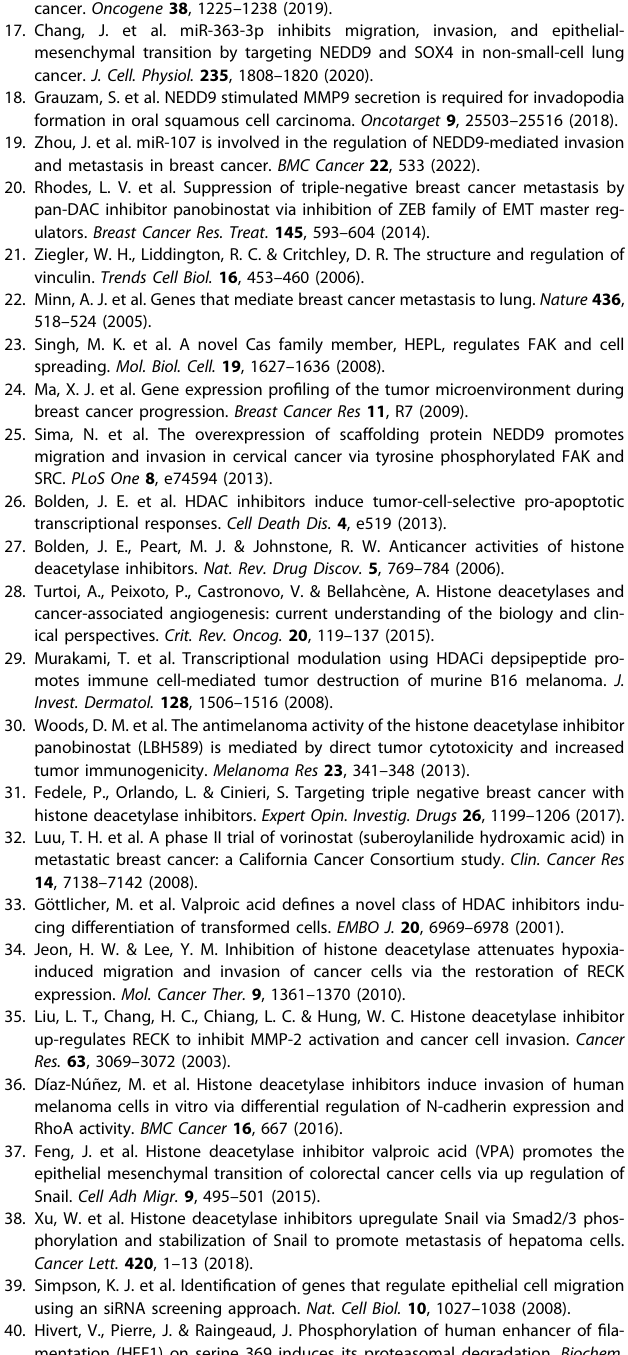
Fig. 6 HDAC4 inhibition upregulates NEDD9 expression and promotes breast cancer cells migration. a ChIP assay of recruitment of Ac-H3K9 to the nedd9 promoter region was observed after cells treatment with LBH589. b Western blotting analysis of NEDD9 expression after cells transfected with indicated siRNA or treated with HDAC4 speci fi c inhibitor tasquinimod. MCF-7 and MDA-MB-231 cells were transfected with two independent HDAC4 siRNAs, then NEDD9 mRNA levels ( c ), nedd9 promoter ChIP assay ( d ), nedd9 promoter luciferase activity ( e ) and cells migration ability ( f ) were examined. Scale bar, 200 μ m. g Invasion ability was restored when HDAC4 was depleted by siRNA in NEDD9 knockdown cells. Scale bar, 200 μ m. h Schematic diagram depicting the regulation of NEDD9 in breast tumor cells by HDAC4 inhibition contributes to breast metastasis. Results are expressed as mean ± SD. Two-tailed Student ’ s t -tests were performed. */# p < 0.05, **/## p < 0.01, ***/### p <